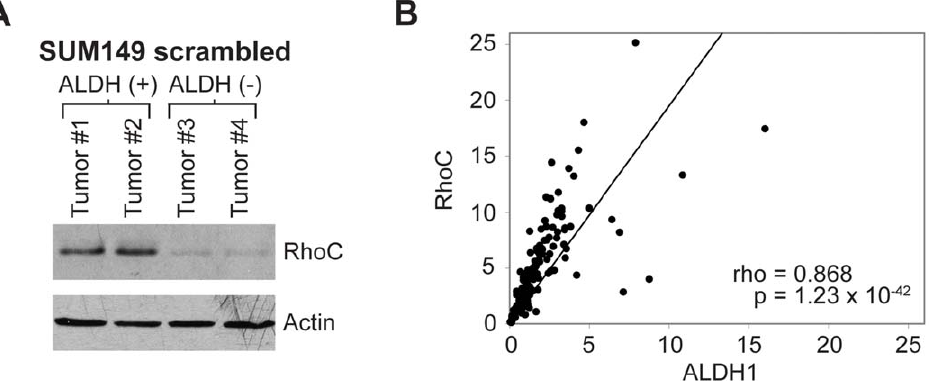
Figure 4. RhoC is tightly associated with the BCSC marker ALDH1 in both xenograft and patient tumors. ( A ) Injecting mice with 5000 SUM149 scrambled cells–at which point both ALDH ( + ) and ALDH ( 2 ) cells form tumors–reveals that ALDH ( 2 ) tumors maintain reduced RhoC levels in vivo . This provides mechanistic evidence for the inability of ALDH ( 2 ) cells to metastasize (their inability to re-express RhoC), and speaks to the inability of ALDH ( 2 ) cells to reconstitute tumor heterogeneity and thus restore tumor RhoC expression through the expansion of RhoC-expressing ALDH ( + ) cells. ( B ) RhoC and ALDH1 expression are highly correlated in clinical breast cancer samples (Spearman’s rho =0.868, p=1.23 6 10 2 42 ,